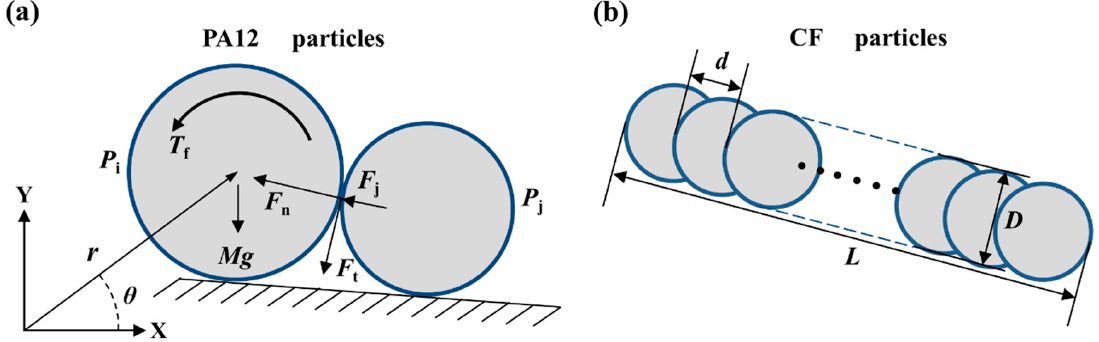
Figure 1. Schematic of the DEM particle model: ( a ) PA12 particles with “soft-spherical” element; ( b ) CF particles with “multi-spherical” element. ( b ) CF particles with “multi-spherical”